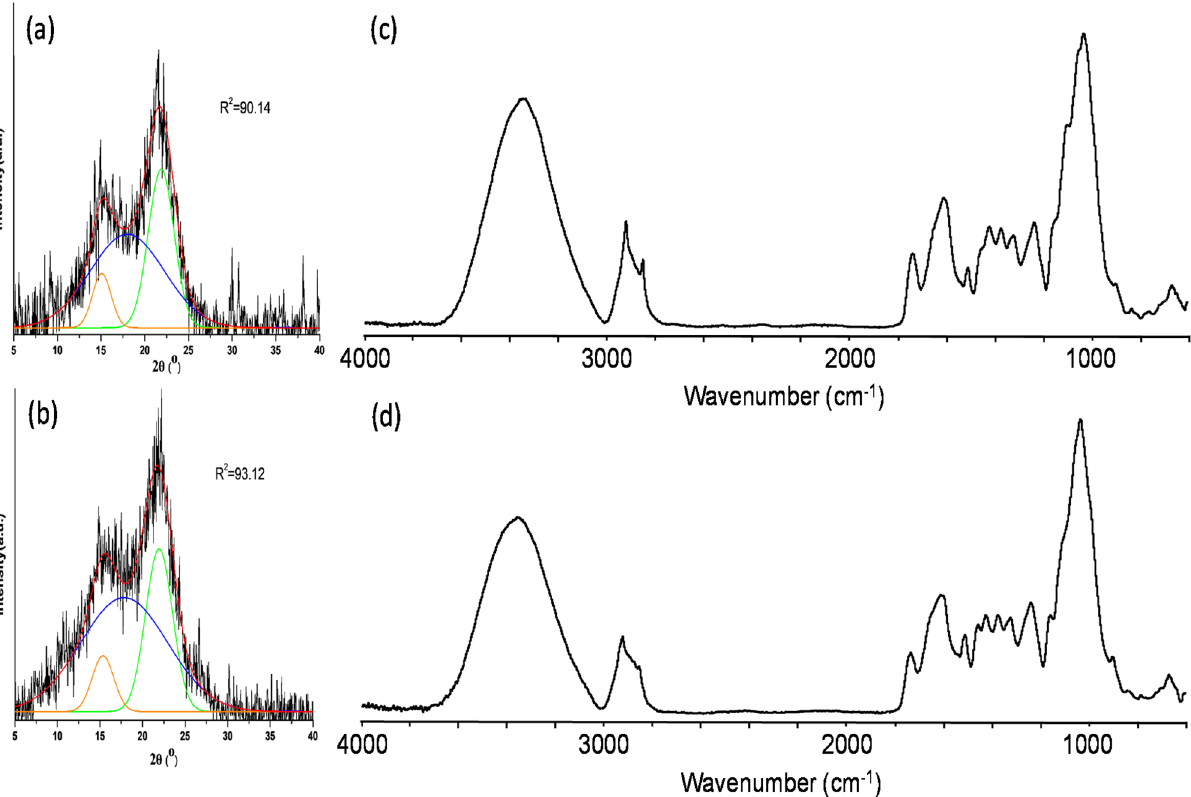
Figure 1. X-ray diffractograms of ( a ) M. oleifera husks (MH), ( b ) D. regia seed pod (RP) and FTIR spectra of ( c ) MH and ( d )